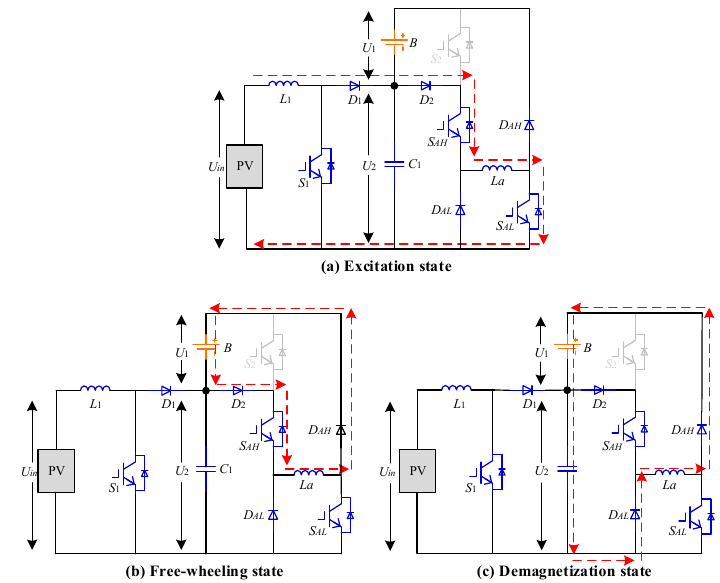
Figure 7. Working states of mode 1. ( a ) Excitation state. ( b ) Free-wheeling state. ( c ) Demagnetization state.